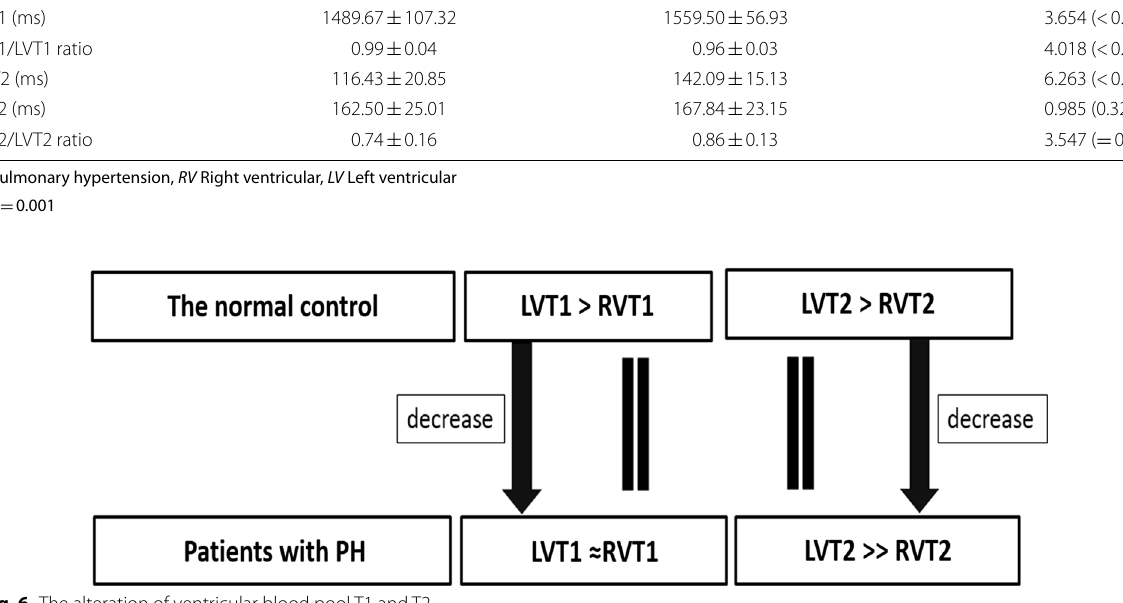
Fig. 6 The alteration of ventricular blood pool T1 and T2